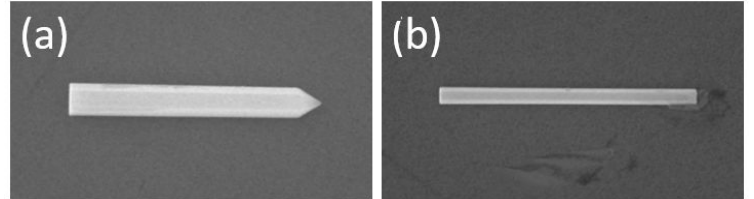
Figure 1. SEM images of the free-lying GaN NWs with the diameters of 350 nm ( a ) and 200 nm ( b ).